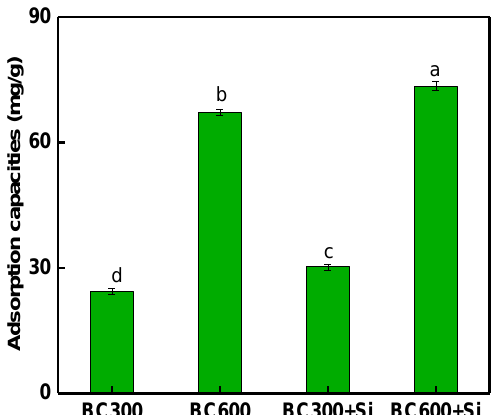
Figure 1. The adsorption capacities of Cu on different BC. BC300 + Si and BC600 + Si are BC modified with 5 M sodium silicate. Values are the mean ± standard deviations, different letters in the same column represent significant difference at p < 0.05 ( n = 3, LSD test).